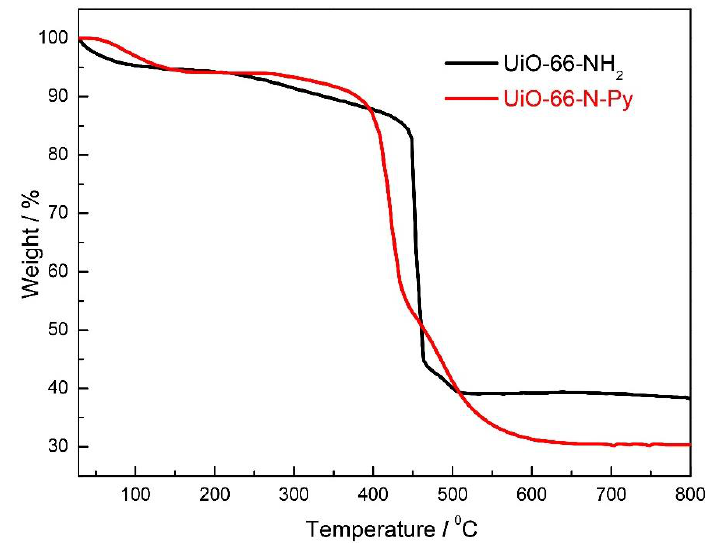
Figure 4. Thermogravimetric analysis (TGA) of UiO-66-N-Py and UiO-66-NH 2 .